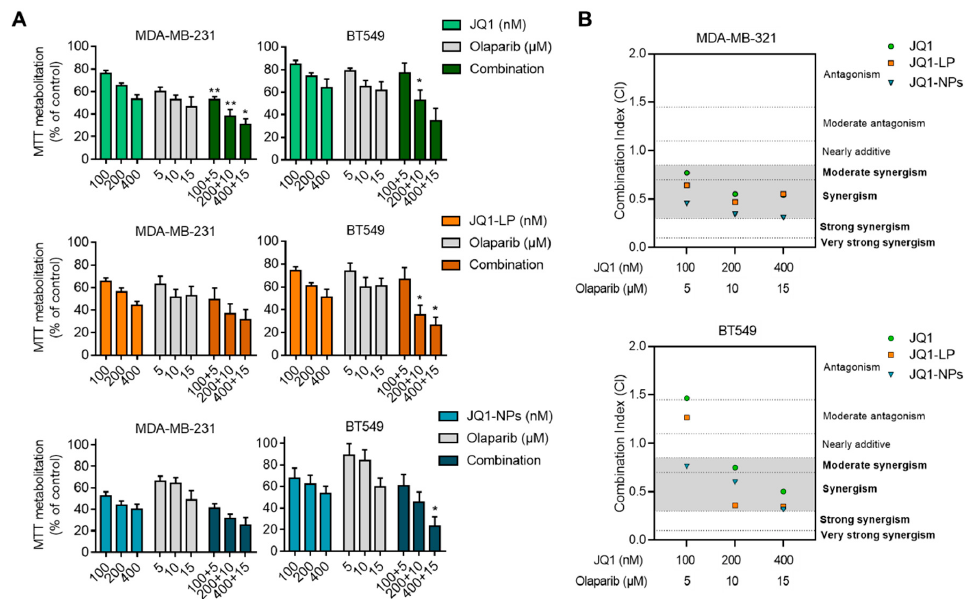
Figure 5. Evaluation of JQ1 encapsulation and olaparib combination in breast cancer cell lines. ( A ) MDA-MB-231 and BT549 cell lines treated with JQ1-free (upper), JQ1-LP (middle) and JQ1-NPs (lower) alone or in combination with olaparibfor 72 h, followed by MTT assays. ( B ) Synergistic studies to evaluate the effect of JQ1-free NPs or encapsulated with olaparib. Combination index (CI) for the different drug combinations obtained using CalcuSyn from viability values obtained in an MTT assay ( A ). CI values lower than 0.8 indicate synergistic action. * p ≤ 0.05 and ** p ≤ 0.01.